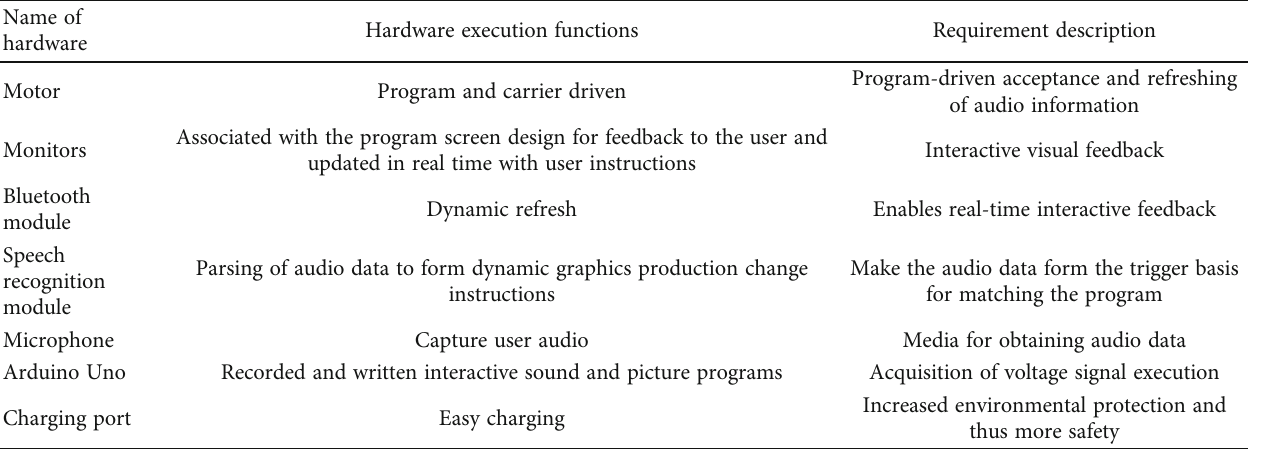
Table 1: List of main hardware